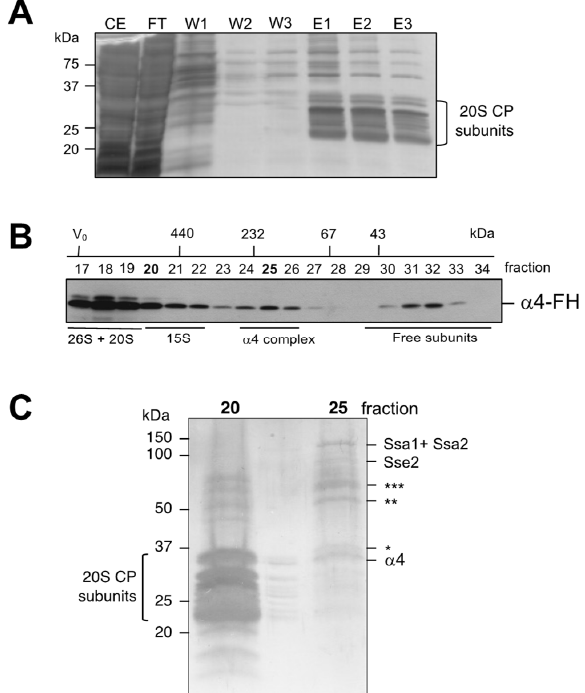
Figure 2. Purification of a low MW complex containing α 4 subunit. ( A ) A strain expressing α 4-FH was utilized to immunoaffinity purify complexes containing α 4 subunit. ( B ) After concentration, the purified material was subjected to a fractionation by size in a Superdex200 column. The α 4 subunit was detected with anti-Flag antibody. ( C ) Polypeptides present in eluted fractions 20 and 25 were detected by silver staining after concentration and SDS-PAGE. The indicated bands of fraction 25 were analyzed by mass spectrometry. Identified polypeptides are marked on the side. Probable contaminants: *** Nut1, negative regulator of Urs2 of the HO promoter, ** Rga1 (RhoGAP for Cdc42); * Tdh, glyceraldehyde-3-phosphate